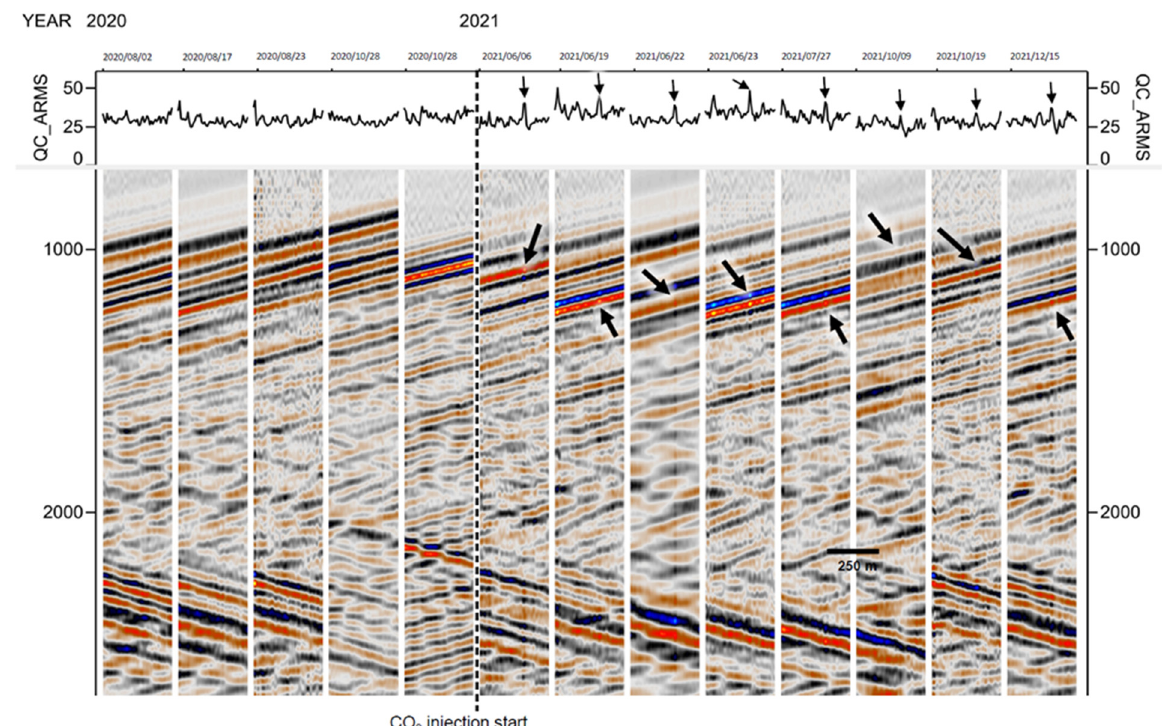
Figure 7. A series of CRC-3 DAS gathers in the depth interval 1380–1630 m for a selection of earthquakes before and after CO 2 injection. Arrows indicate an amplitude peak in injection interval.